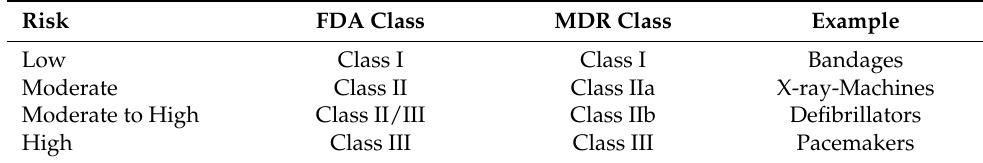
Figure 2. Software safety classification according to IEC62304 [38]. Table 1. Medical device classification according to FDA and